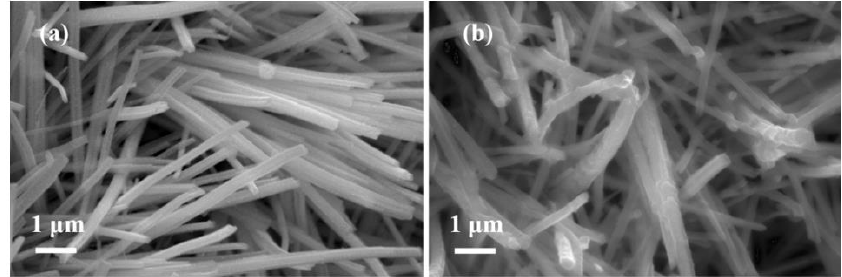
Figure 4. SEM images of ( a ) neat NiMoO 4 NWAs and ( b ) NiMoO 4−x @C samples.